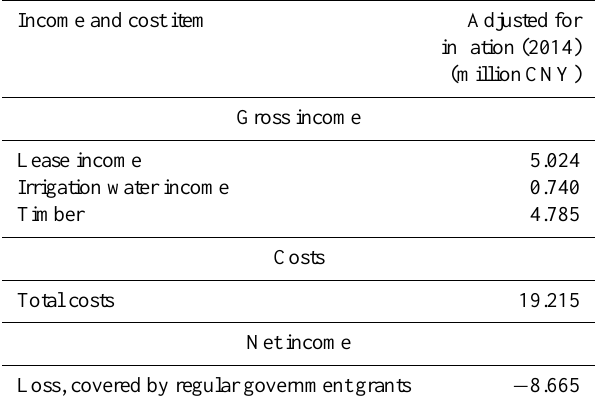
Table 7. Annual incomes of and costs to the Water and Forest Man- agement Station for Kökyar